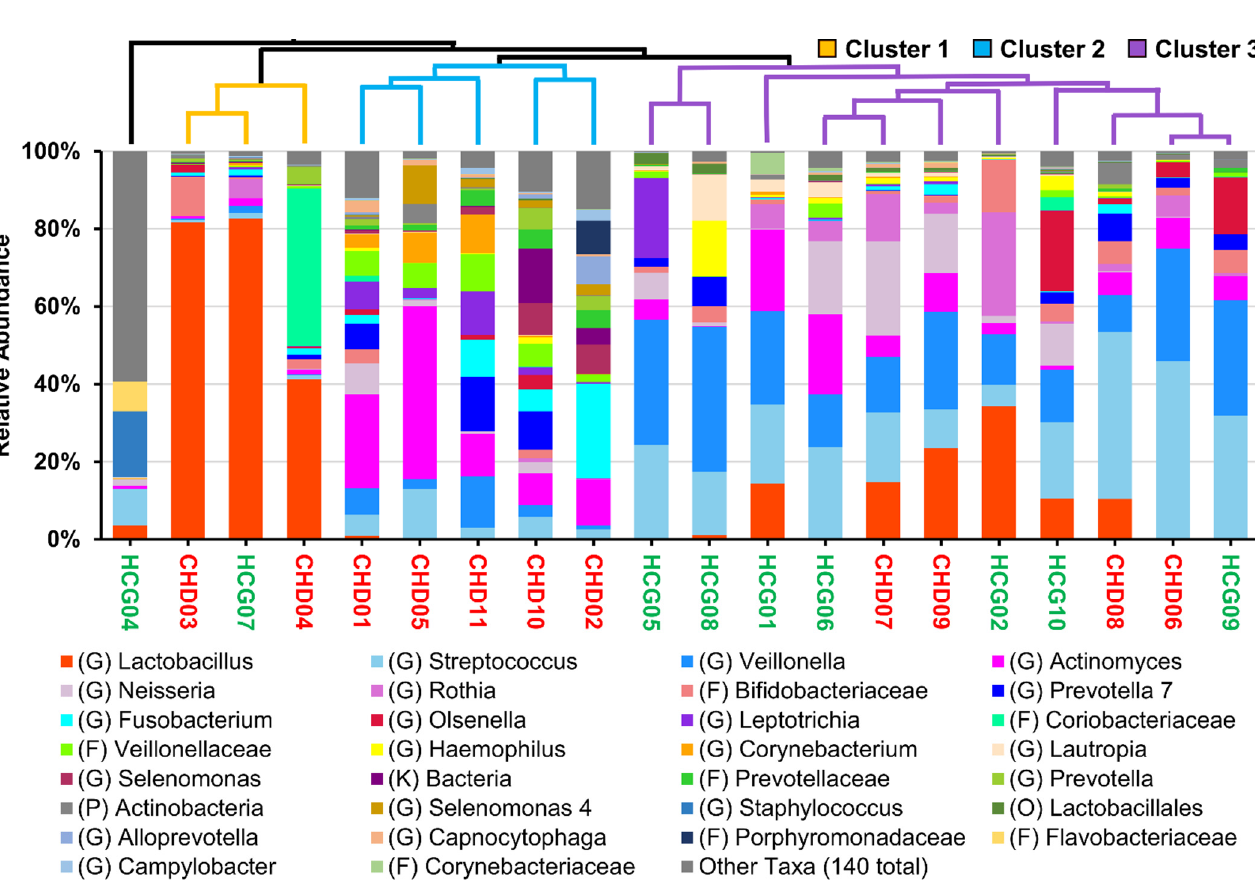
Figure 3. Boxplot diagram based on the number of OTUs observed at a sampling depth of 3000 reads for the children with CHD and a HCG ( A ). PCoA of Bray–Curtis dissimilarity for the CHD and HCG samples ( B ).